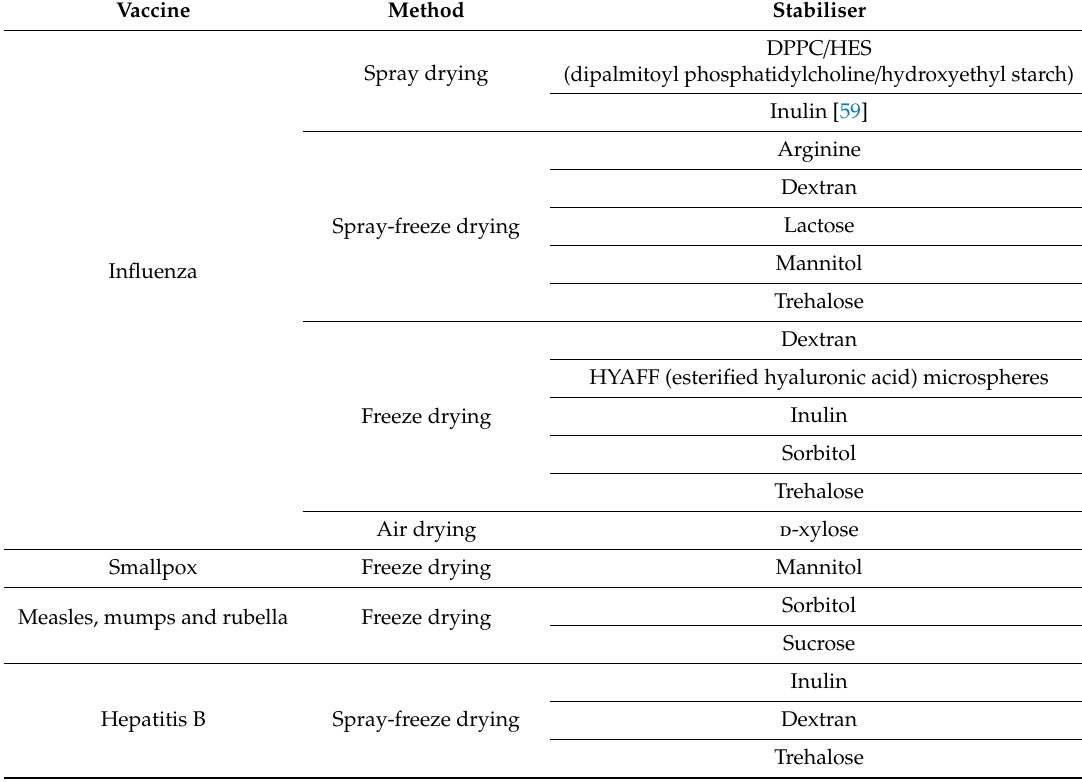
Table 3. Stabilisers used in vaccines during the drying process